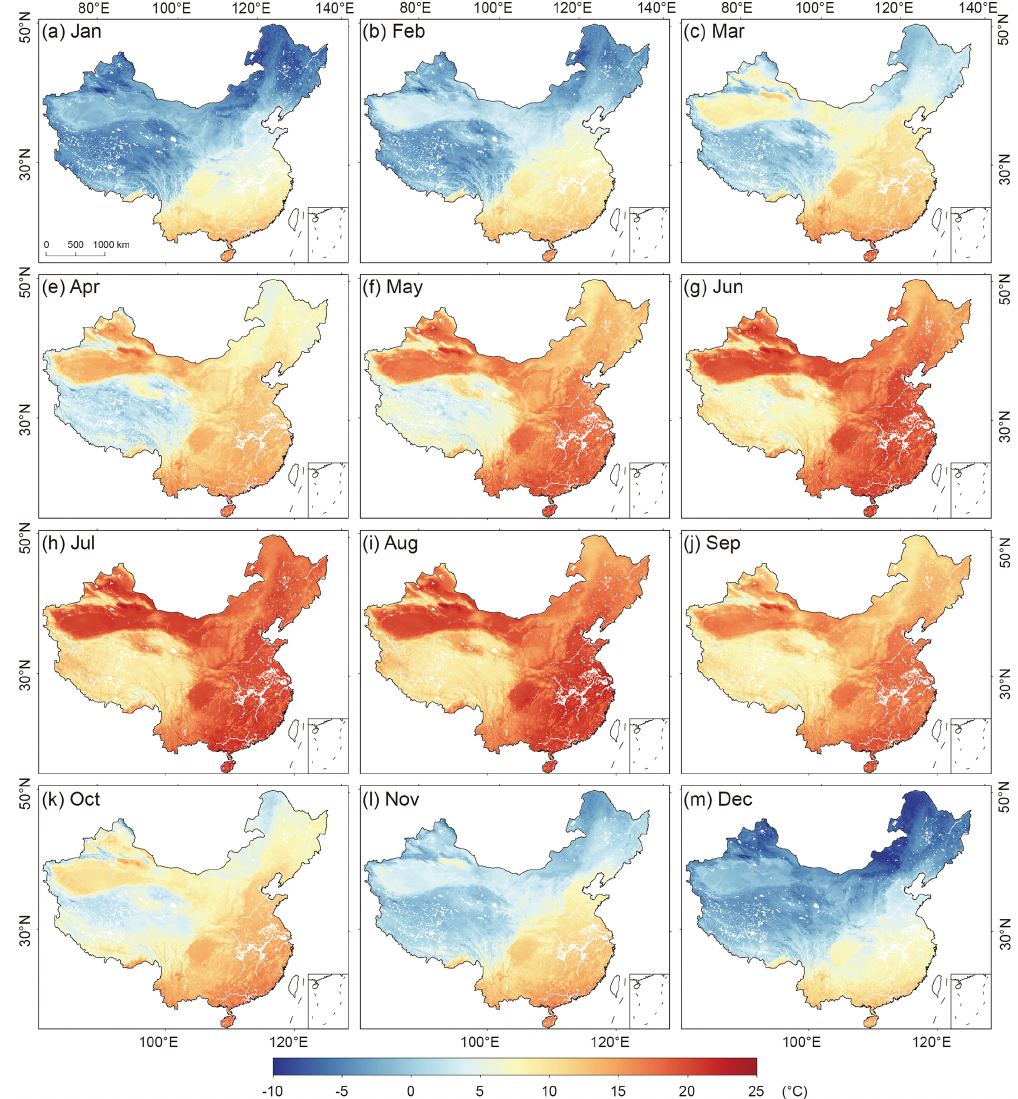
Figure 9. Spatial distributions of the monthly mean ET over the mainland of China in